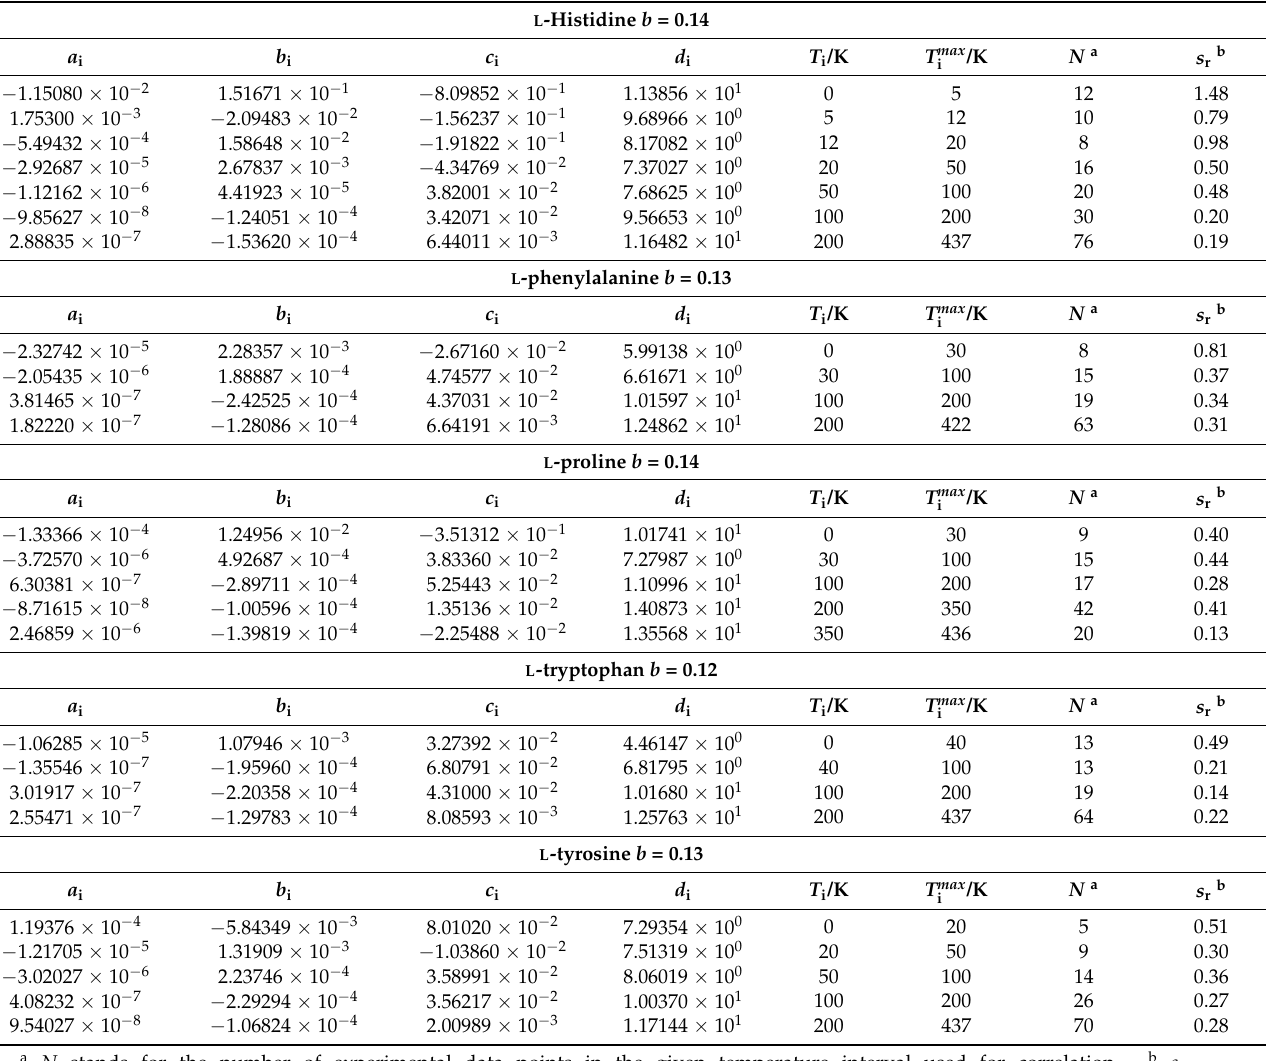
Table 4. Parameters of Equations (1) and (2) for crystal heat capacities in J K − 1 mol − 1 . L -Histidine b =